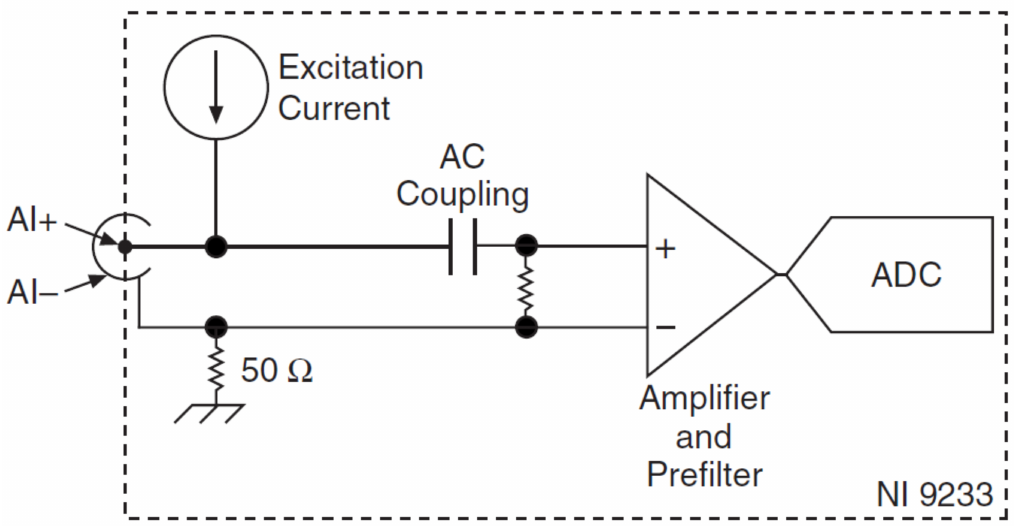
Figure 4. Scheme of a channel of the acquisition board NI